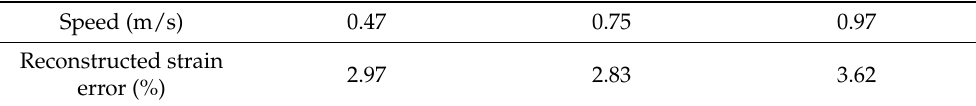
Figure 23. Identified front, rear, and resultant load in comparison with the static axle load and static weight of the vehicle (speed: 0.75 m/s). Table 13. The percentage error at different levels of